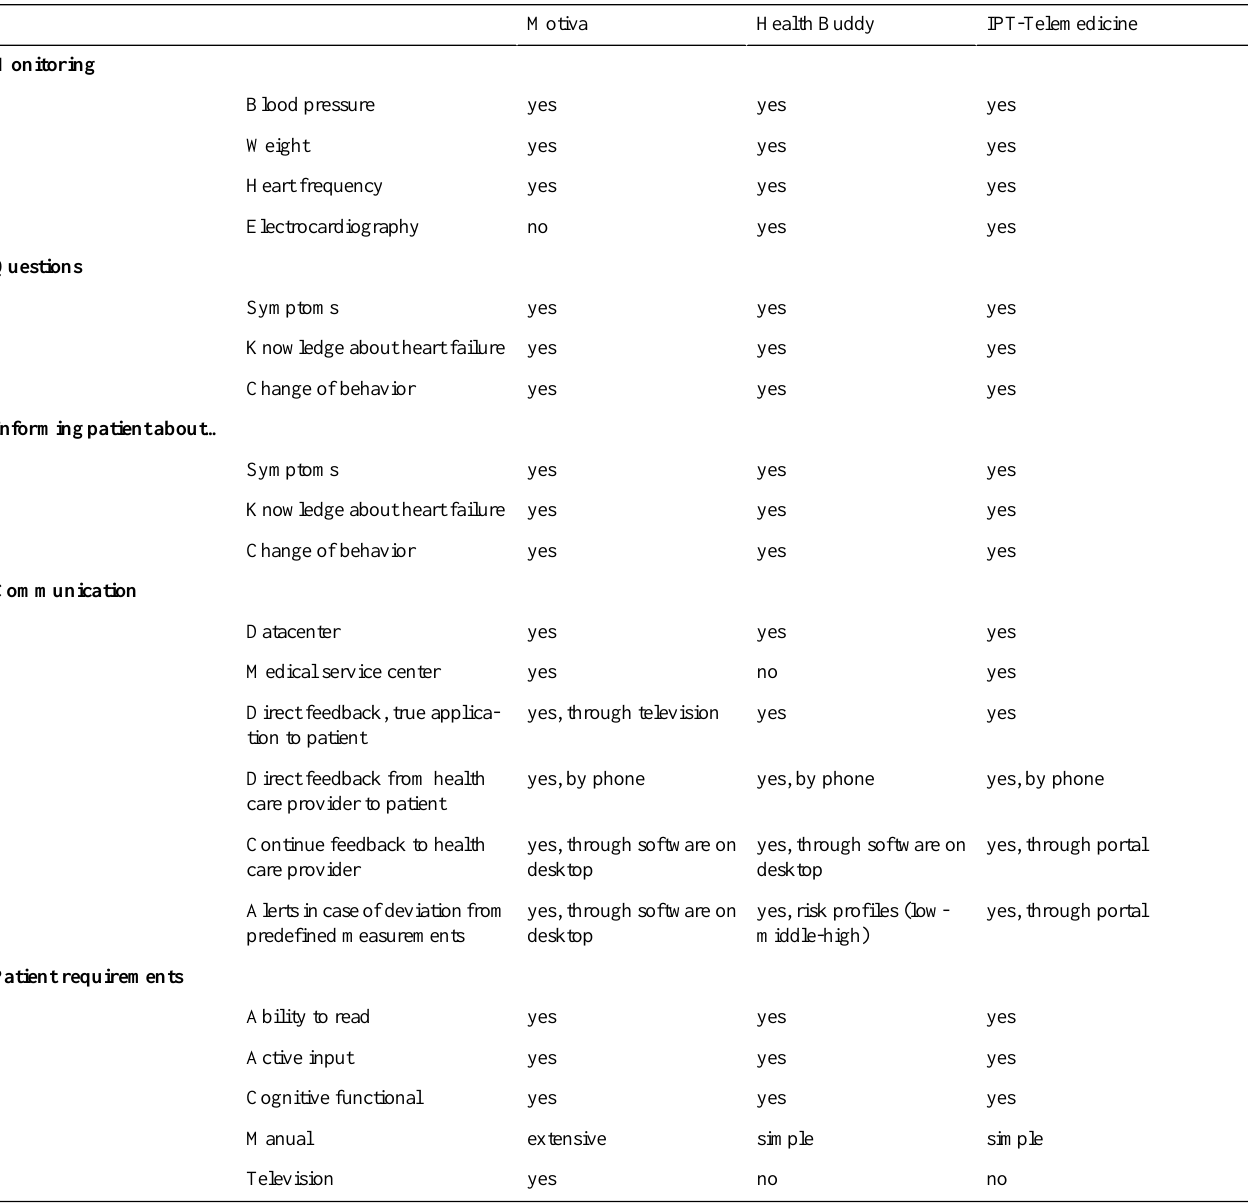
Table 1. Characteristics of the commercial available telemonitoring systems used in this study.